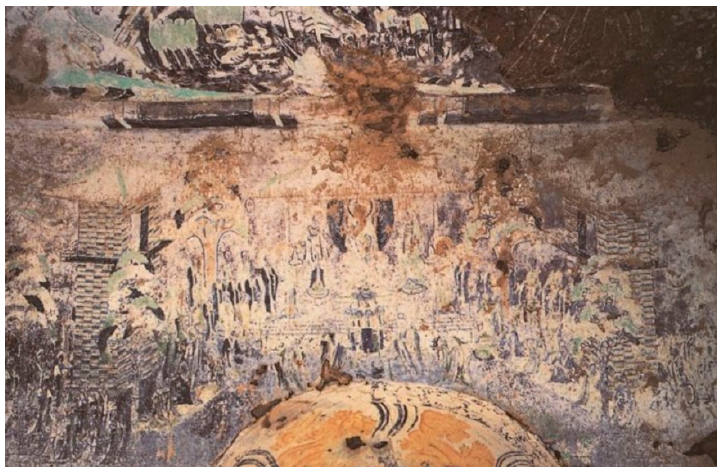
Figure 3. West Pure Land, Maijishan 127, early-sixth-century Gansu.